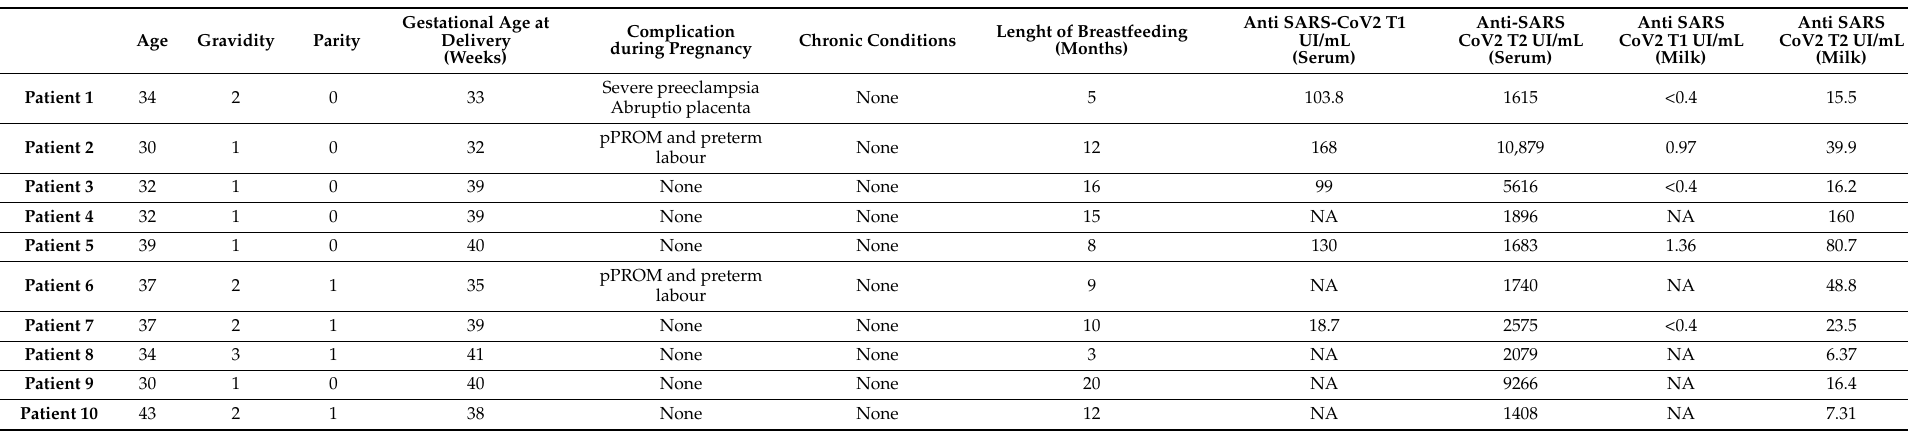
Table 1. Main characteristics and antibodies levels in serum and milk samples of the study